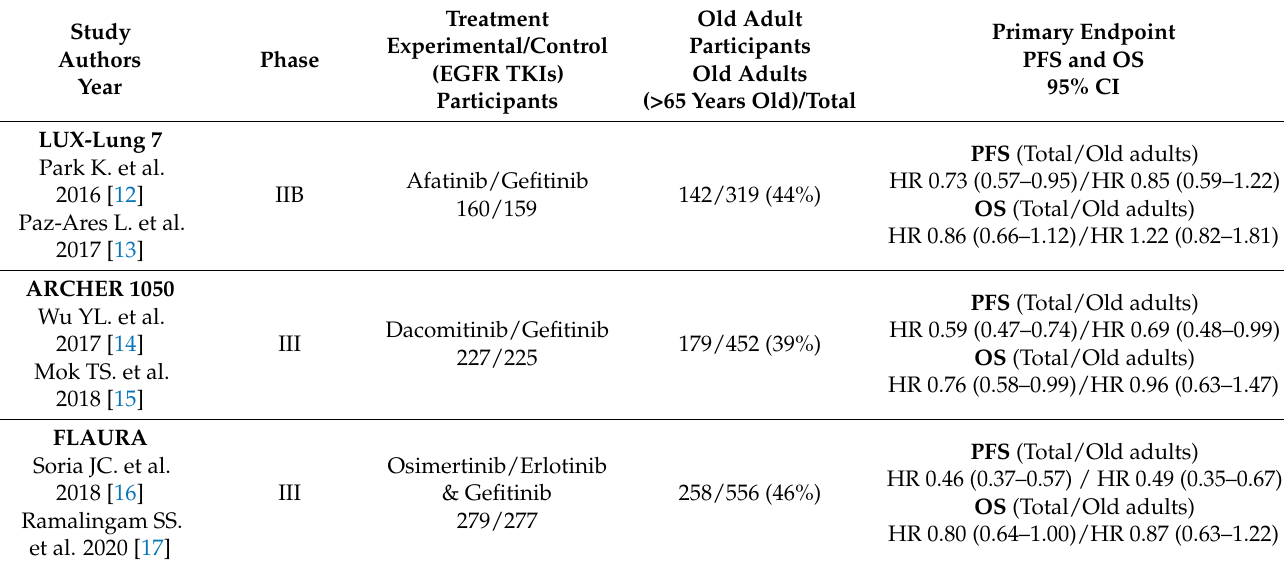
Table 1. Characteristics of the analyzed trials.